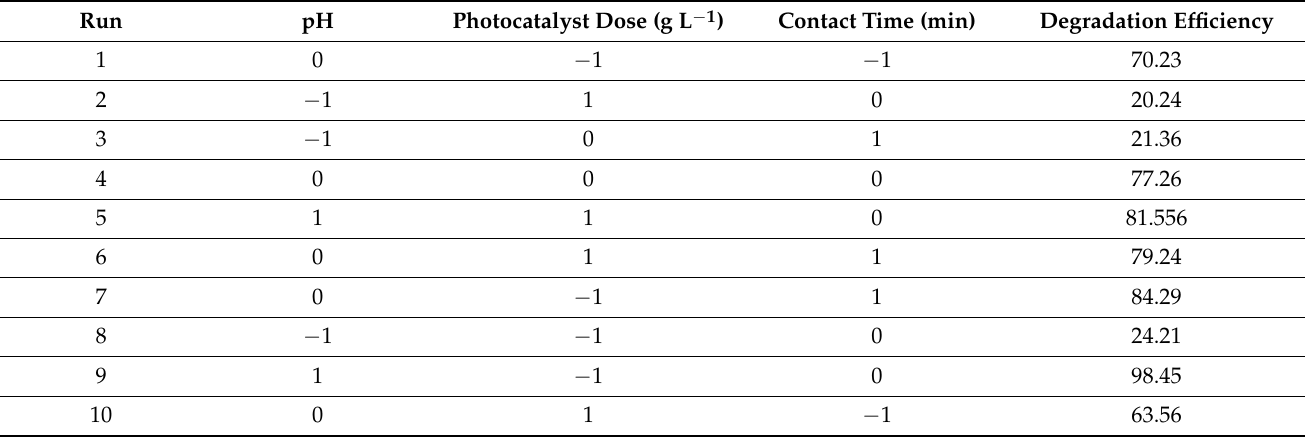
Table 6. A randomized design matrix for Box–Behnken methodology and observed responses for malathion degradation using HNFs.